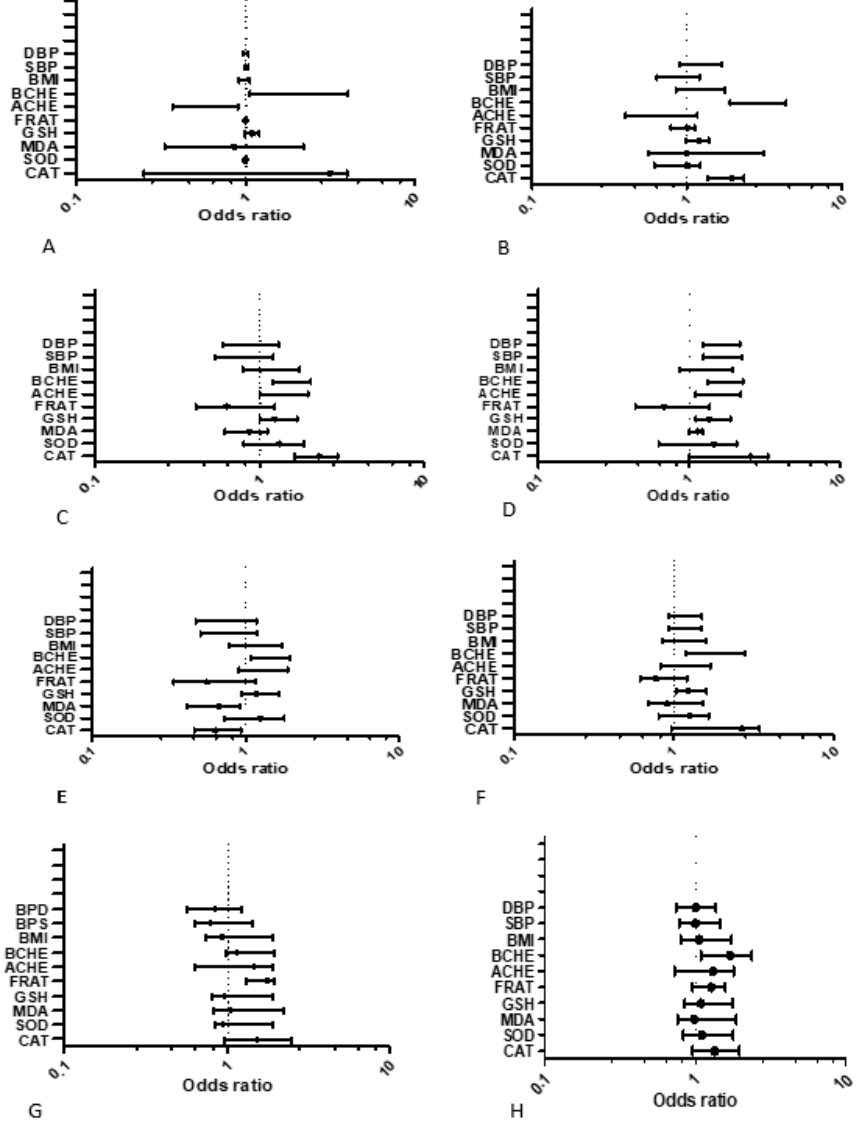
Figure 3. Multiple Logistic regression (MLR) analysis of genetic polymorphisms (SNPs) in dominant model according to Biochemical Variables of OPs-exposed population: The model was adjusted for each SNPs (0: major homozygote; 1: heterozygote + minor homozygote). The results were significant if p ≤ 0.05. ( A ) MLR for GSTP1 gene of Pakistan; ( B ) MLR for GSTP1 gene of Cameroon; ( C ) MLR for catalase gene of Pakistan; ( D ) MLR for gene of exposed Cameroon; ( E ) MLR for BCHE gene of Pakistan; ( F ) MLR for BCHE gene of Cameroon; ( G ) MLR for ACHE gene of Pakistan; and ( H ) MLR for ACHE gene of